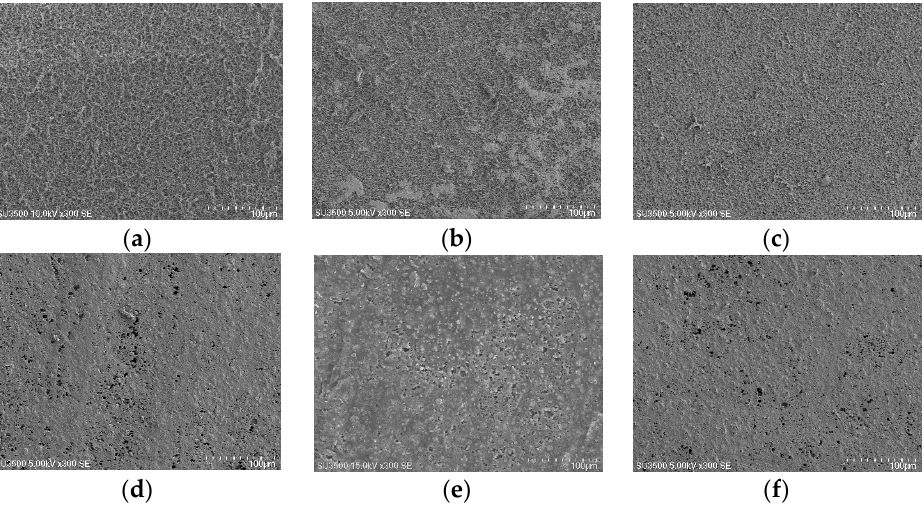
Figure 2. SEM images of modified and unmodified membrane surface before antibacterial test: ( a ) Pure PVDF; ( b ) PVDF15; ( c ) PVDF 30; ( d ) Pure PES; ( e ) PES15; and ( f ) PES30. Scale bar: 100 μm.